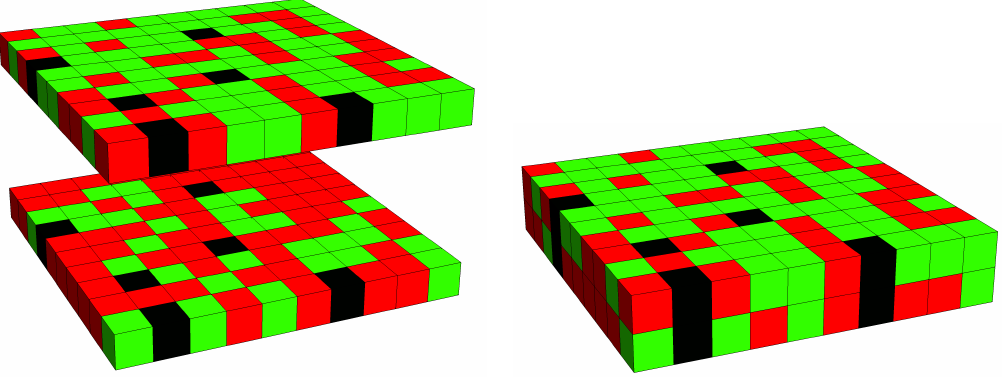
Figure 1. Lattice model for a mixed lipid bilayer that contains transmembrane proteins. The snapshot shows the two membrane leaflets separated (left diagram) and merged into a bilayer (right diagram). Positions of lipids of type A (green) and lipids of type B (red) are uncorrelated across the lattice. Number and locations of transmembrane protein segments (black) are identical in the two leaflets. Note that both leaflets may have different lipid compositions. The displayed snapshot corresponds to a square lattice ( z = 4) of size M = 10 × 10 and mole fractions φ = A ext / M = 0.62 (the upper leaflet), ψ = A int / M = 0.30 (the lower leaflet) and α = P / M =